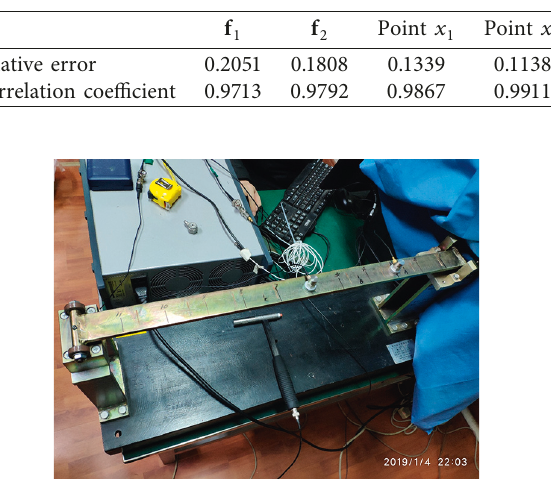
Real force Identified force by sensor 1 Identified force by sensor Figure 13: The reconstruction of the impact F